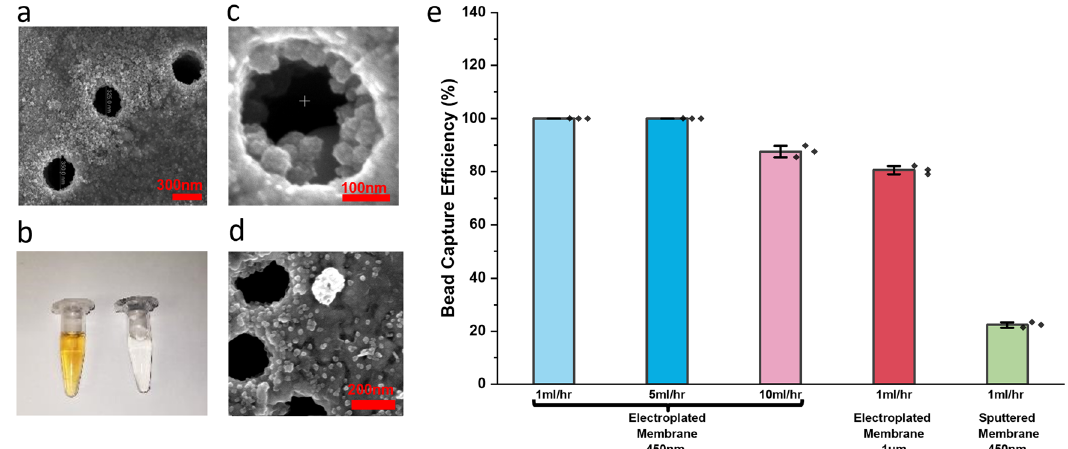
Fig. 3 Characterization of the magnetic beads capture of MNM. a SEM image of captured magnetic beads near the edges of nanopores by the monopole fi eld. The diameter of the pore has decreased to around 300 nm after the deposition of different metallic layers. b Solution of beads before passing through the magnetic nanoporous membrane (left) and after fi ltering through the magnetized membrane (right). The yellow color indicates the concentrated beads. c Zoomed-in SEM image shows nanobeads captured inside a single nanopore by the dipole fi eld of the wedge junction. d SEM image of mouse plasma exosome captured near the nanopore. e Bead capture ef fi ciency of sputtered and electroplated membranes at different fl ow rates and pore sizes. For the electroplated membrane, the original pore size of 450 nm and 1 μ m and fl ow rates of 1, 5, and 10 mL/h have been tested. For the sputtered membrane, the original pore size of 450 nm and fl ow rate of 1 mL/h have been tested ( n = 3 independent experiments). Error bars indicate the standard deviations (SD) for each condition.